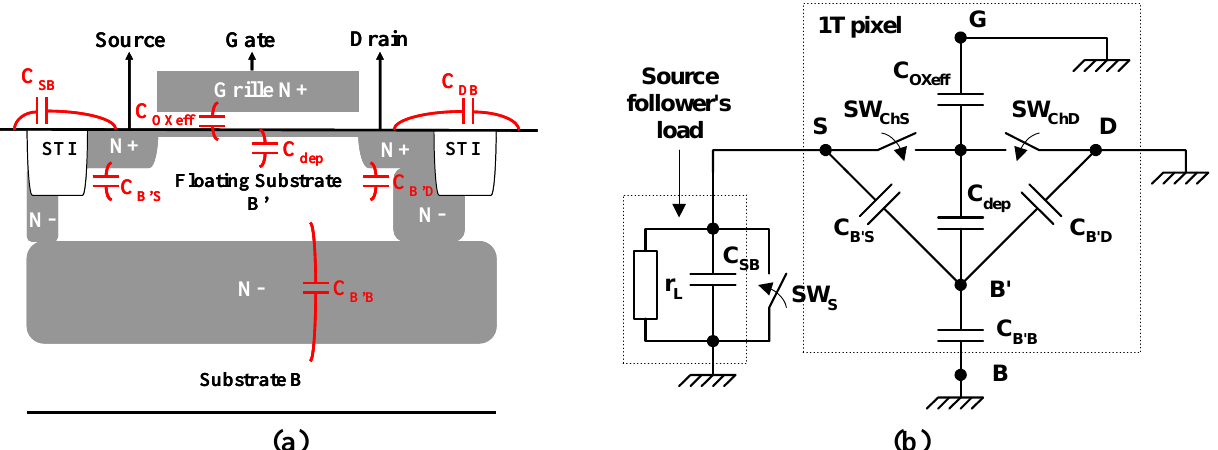
Figure 4. (a) 1T pixel structure with indication of capacitances. (b) Its ac equivalent